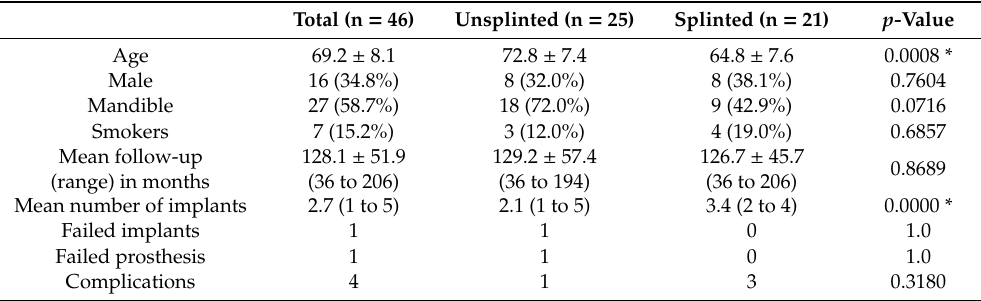
Table 1. Patients’ characteristics.